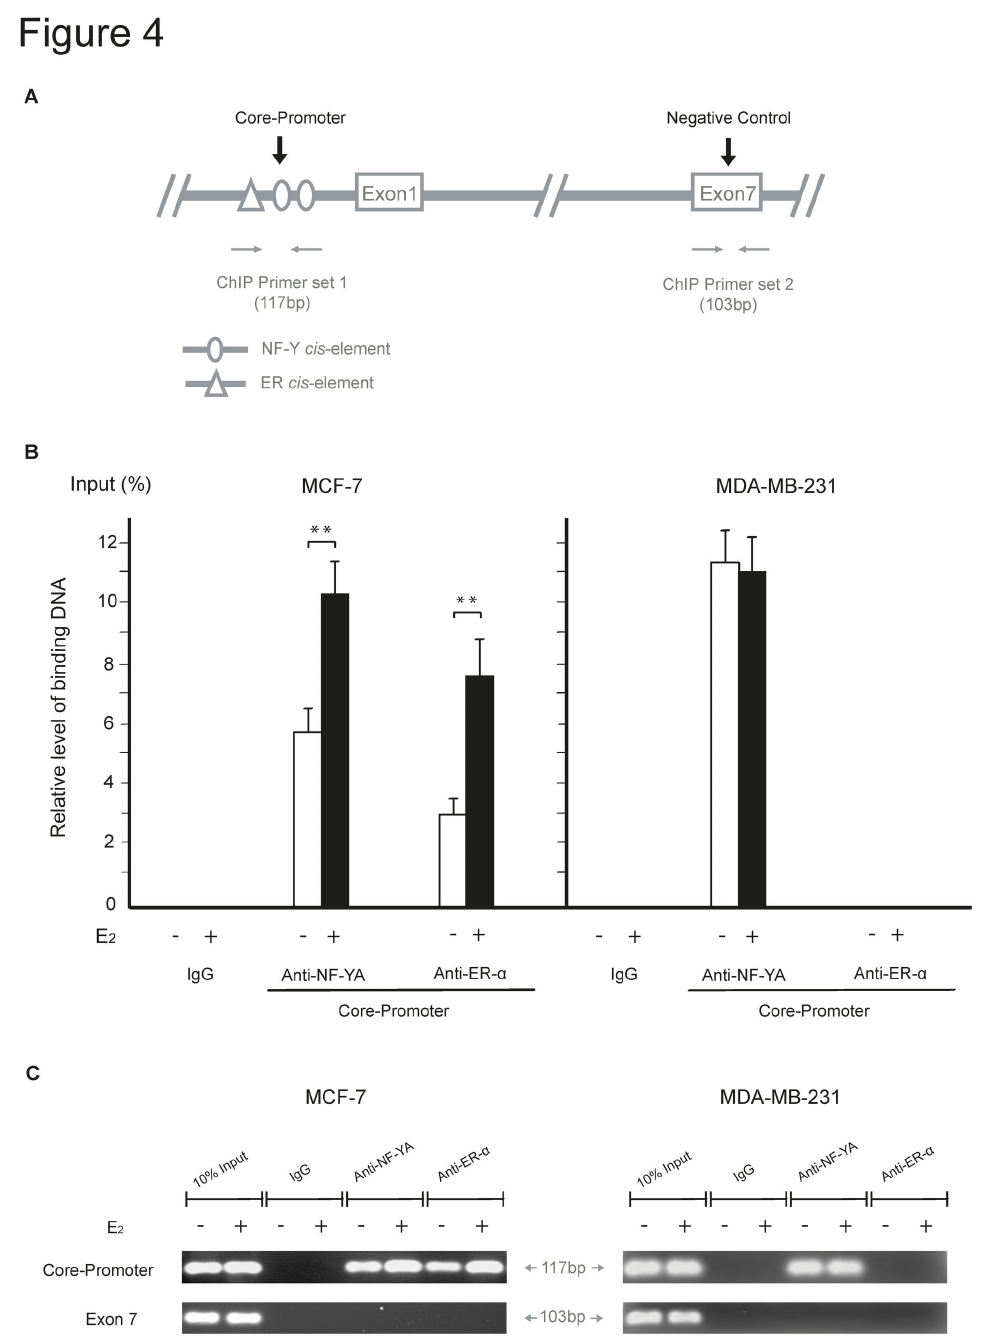
Figure 4. Recruitment of ER-α and NF-Y to the UBC9 promoter in vivo . ( A ) Schematic representation of the UBC9 gene including the proximal promoter with the putative transcription factor binding sites and the negative control region ( UBC9 exon 7). Primer pairs are indicated by arrows. ( B ) ChIP assays using anti-ER-α, NF-YA or IgG control antibodies were performed on chromatin isolated from cells cultured in phenol red-free medium in the absence (white bars) or the presence (black bars) of E 48 hours. The equivalent fraction of the sonicated chromatin was set aside as 'input' DNA (non-immunoprecipitated) before the antibody affinity manipulations. Data were presented as relative amount of immunoprecipitated DNA normalized to input as measured by quantitative PCR assay, and were given as mean ±SD obtained in four separate experiments. **P<0.01 (Student’s t - test). ( C ) Ethidium bromide staining of the PCR products of the UBC9 promoter region (upper panel) and UBC9 exon 7 control region (lower panel). doi: 10.1371/journal.pone.0075695.g004 PLOS ONE |